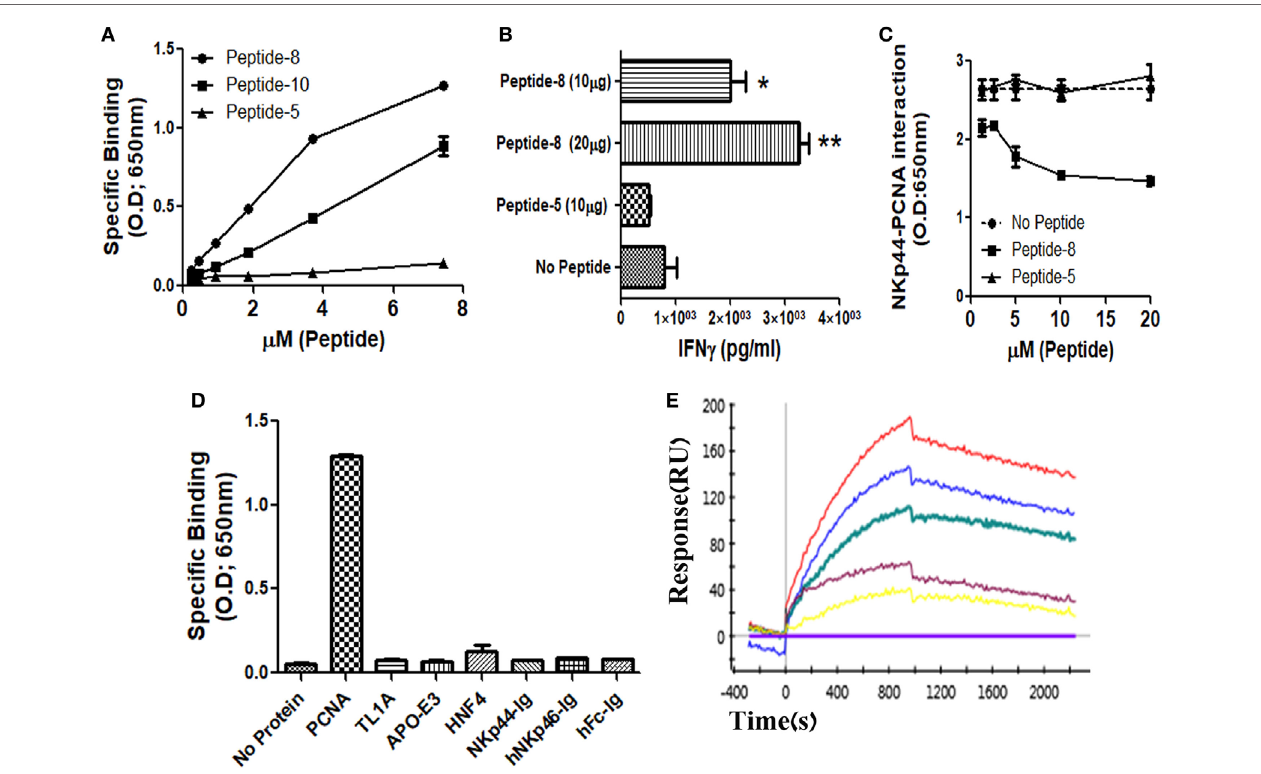
FigUre 1 | Recognition of recombinant human PCNA (hPCNA) by NKp44-derived pep8 (NKp44-pep8). (a) ELISA assay representing the binding curve of biotinylated NKp44-derived pep5, pep8, and pep10 at a peptide concentration range of 0–7.24 µM to plate bond hPCNA. (B) IFN γ secretion assay of NK92-44-1 cells co-incubate with the HLA positive cell line PANC-1 (E:T ration of 1:2) in the presence of NKp44-pep8 (10 or 20 μ g/well), NKp44-derived pep5 was used as negative control. Note that when we apply to NK92-44-1 pep8 (without target cells), activation of IFN γ secretion is minimal and less/similar to the observed activation when applying the pep5 negative control. (c) ELISA assay of blocking NKp44–proliferating cell nuclear antigen (PCNA) interaction via NKp44-pep8. NKp44-derived pep5 was used as a negative control. No peptide represents the maximal binding capacity of NKp44 to hPCNA. (D) ELISA assay showing the specific recognition of NKp44-pep8 (5 µg/ml) to hPCNA relative to TL1A, APO-E3, HNF4, NKp44-Ig, hNKp46-Ig, hFc. (e) ProteOn array showing the binding of hPCNA at protein concentration range of 0–250 nM to bond NKp44-pep8. 0 nM (X base-line), 15.6 nM (yellow), 31.2 (purple), 62.5 nM (green), 125 nM (blue), and 250 nM